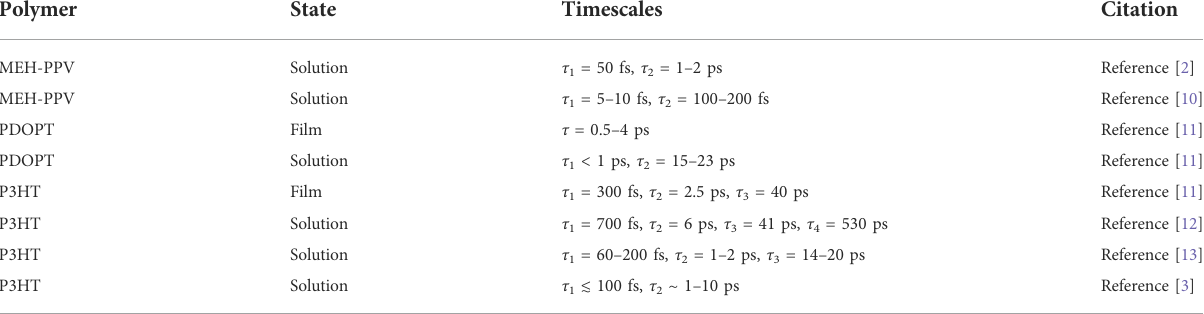
TABLE 1 Some of the dynamical timescales observed in conjugated polymers whose associated physical processes are summarized in Table 2. Reproduced from J. Phys. Chem. Lett. 12, 5344 (2021) with the permission of ACS publishing.